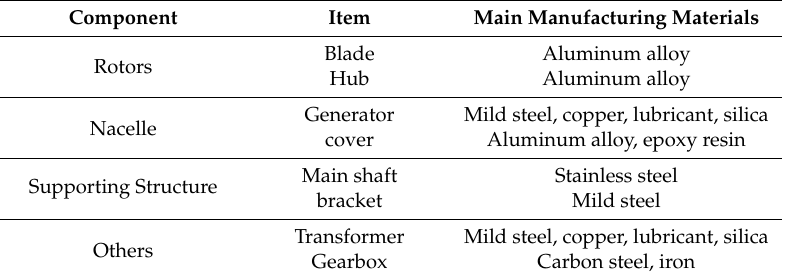
Table 7. Main components and key manufacturing materials of the wind turbine.